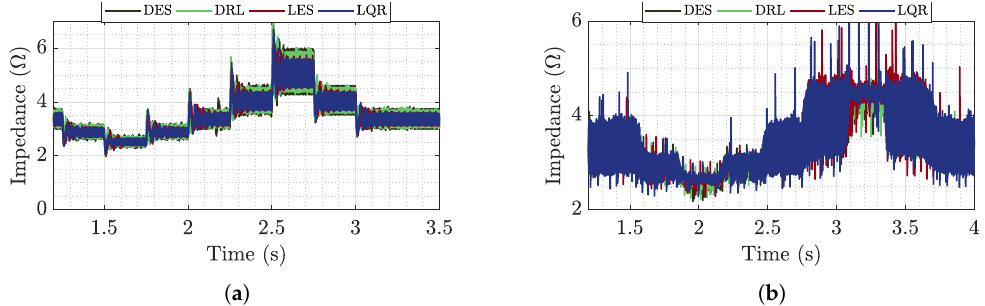
Figure 29. Impedance of the CPL boost in time during the ( a ) simulation and ( b )